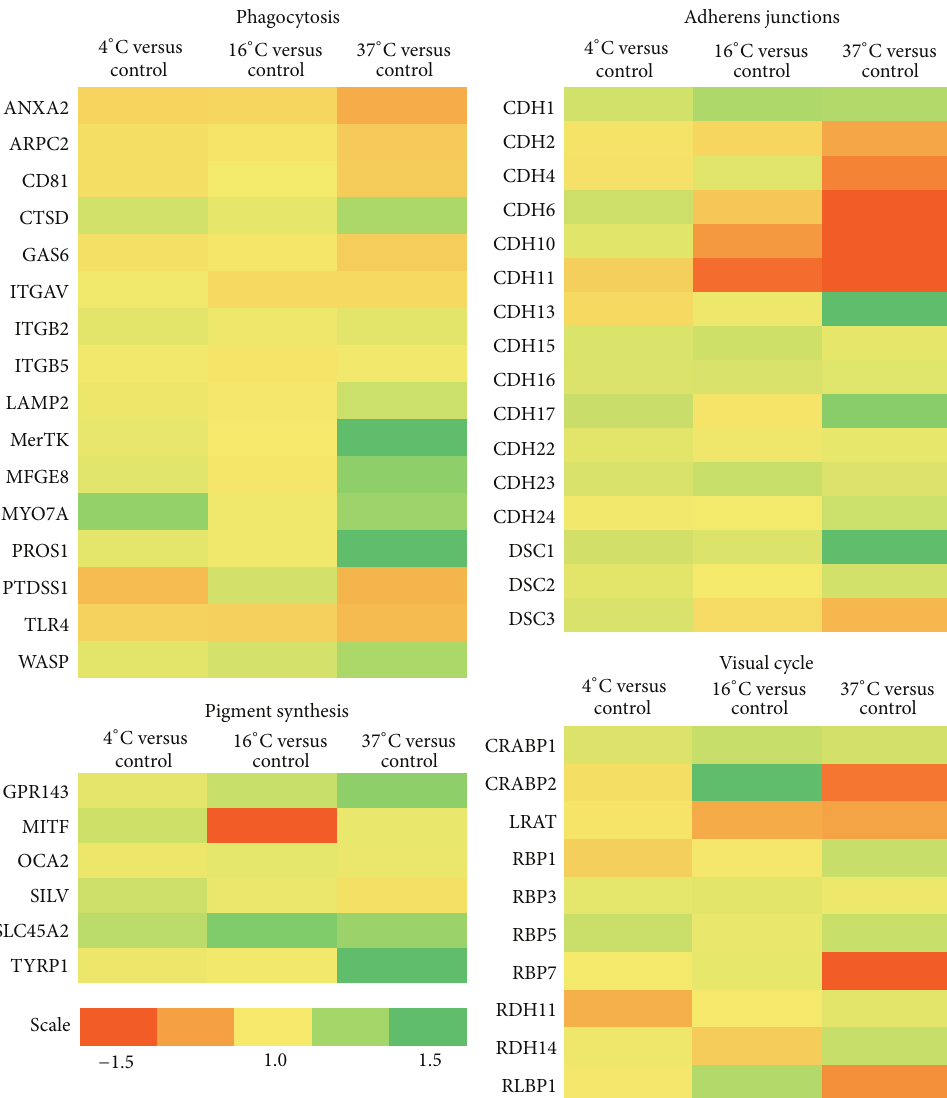
Figure 1: Heat map diagrams of a selection of the most important genes related to RPE phagocytosis, pigment synthesis, adherens junctions, and visual cycle, respectively. The color scale illustrates the relative expression level of mRNAs: green color represents a high expression level and orange color represents a low expression